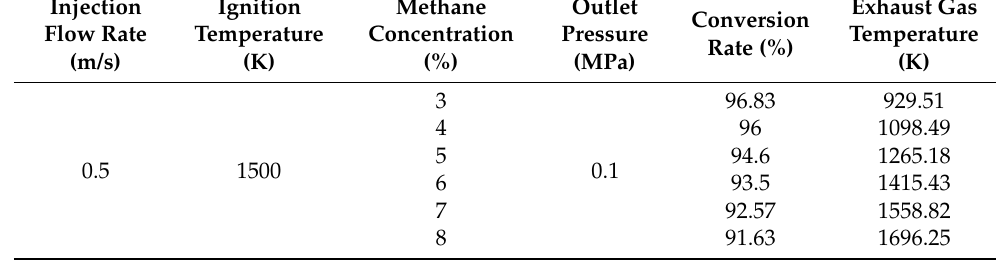
Table 2. Simulation parameters of the influence of Methane Concentration on Conversion Rate and Exhaust Gas Temperature.